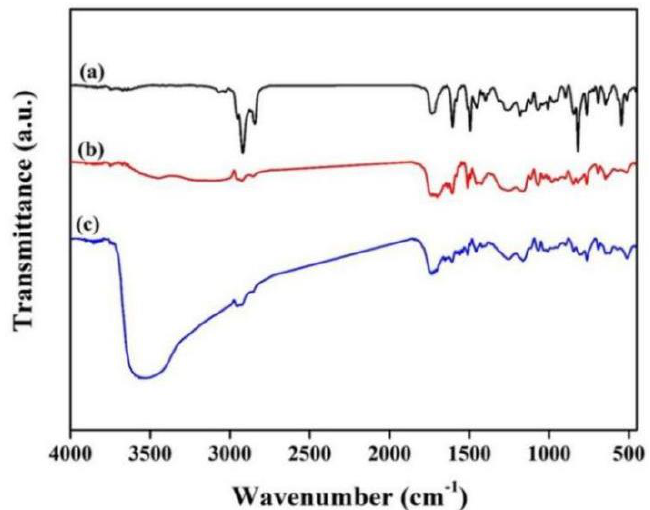
Figure 8. FTIR spectra of ( a ) CLC PC films, ( b ) CLC-PAA PC films, and ( c ) CLC-PAA urease PC films, respectively.